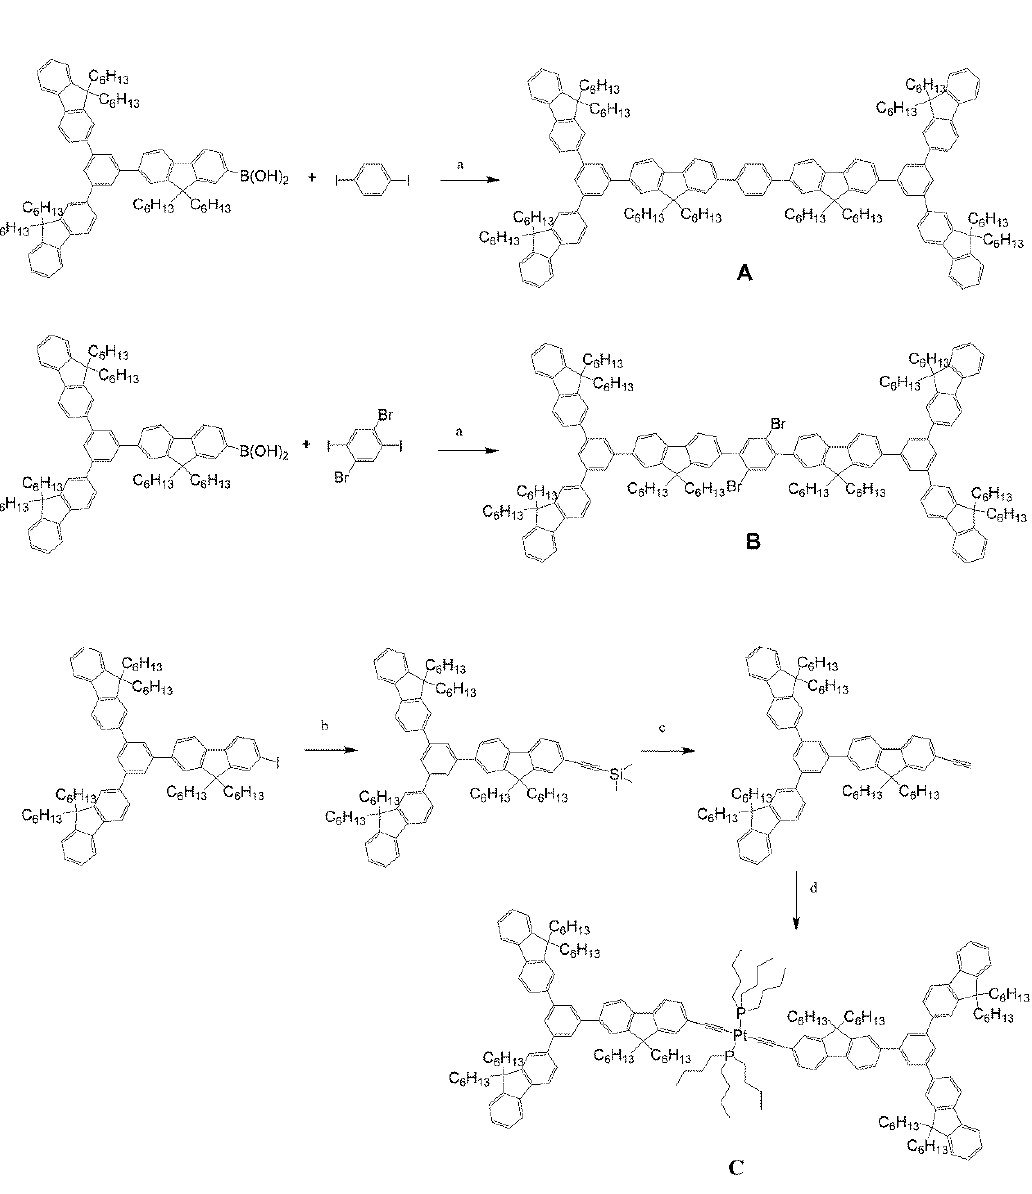
Figure 1. Molecule ”A”, “B”, and “C”. ( a ) Pd(PPh 3 ) 4 , toluene/Na 2 CO 3 1N; ( b ) TMSA, PdCl 2 (PPh 3 ) 2 , Figure 1. Molecule “A”, “B”, and “C”. ( a ) Pd(PPh 3 ) 4 , toluene / Na 2 CO 3 1N; ( b ) TMSA, PdCl 2 (PPh 3 ) 2 , CuI, THF/Et 3 N; ( c ) K 2 CO 3 , MeOH/THF; ( d ) PtCl 2 (PBu 3 ) 2 , CuI, Et 3 N. CuI, THF / Et 3 N; ( c ) K 2 CO 3 , MeOH / THF; ( d ) PtCl 2 (PBu 3 ) 2 , CuI, Et 3